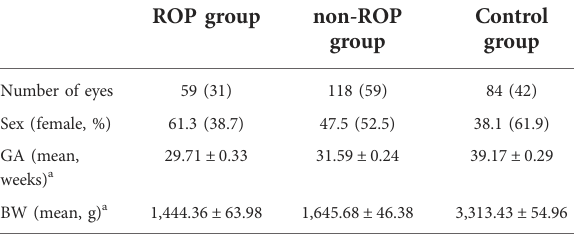
TABLE 1 Characteristics of subjects in 3